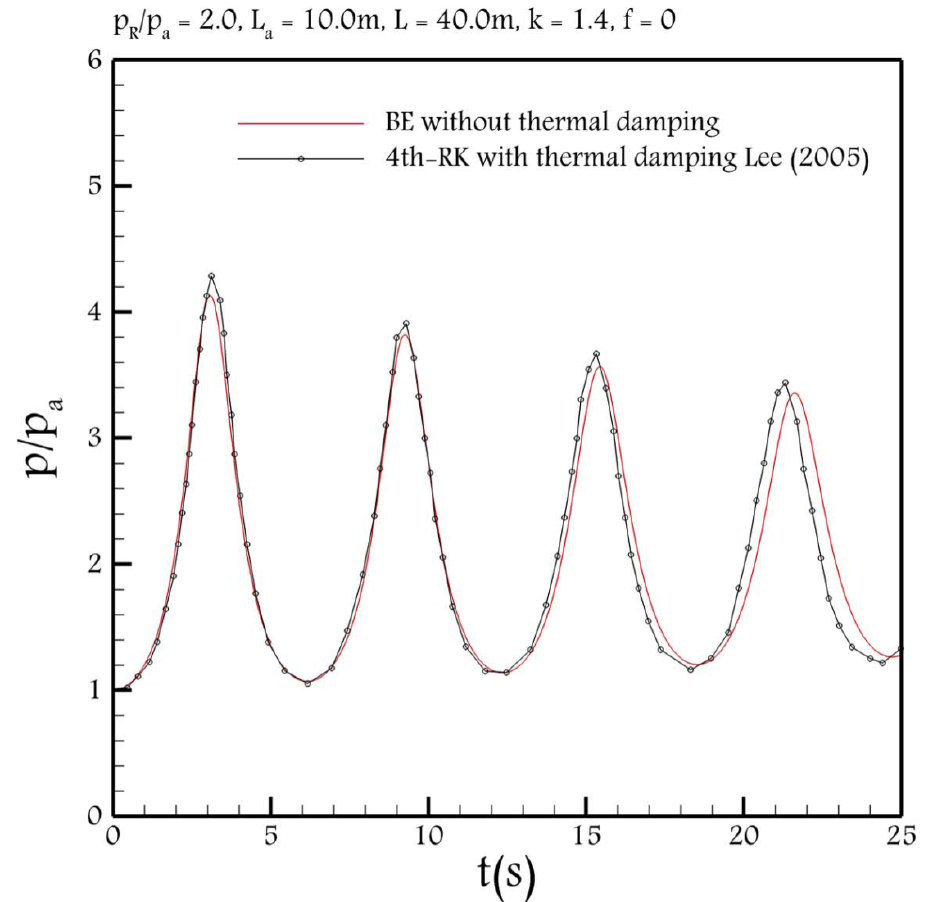
Figure 8. The non-dimensional air absolute pressure (𝑝 𝑝 (cid:3028) ⁄ ) distribution vs. the time, calculated by backward Euler scheme without thermal damping, and the result calculated in [7] and illustrated in [7] (Figure 3.10) by 4th order Runge–Kutta scheme with thermal damping, p R